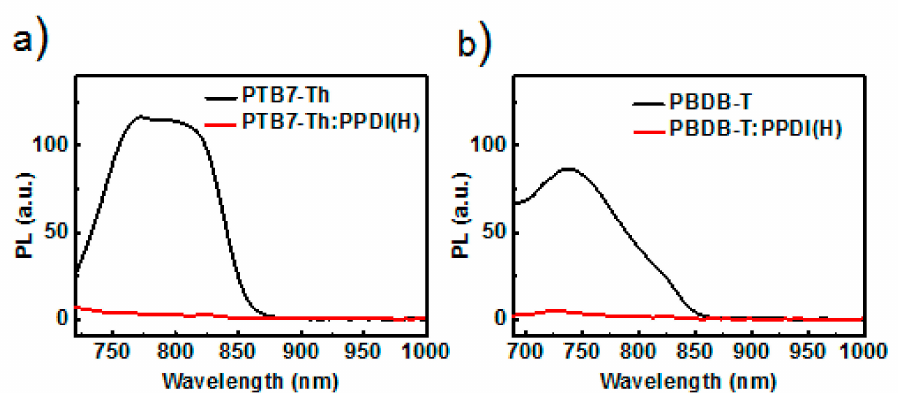
Figure 4. Photoluminescence spectra of PTB7-Th: PPDI(H) blend film ( a ); and PBDB-T: PPDI(H) blend film ( b ).